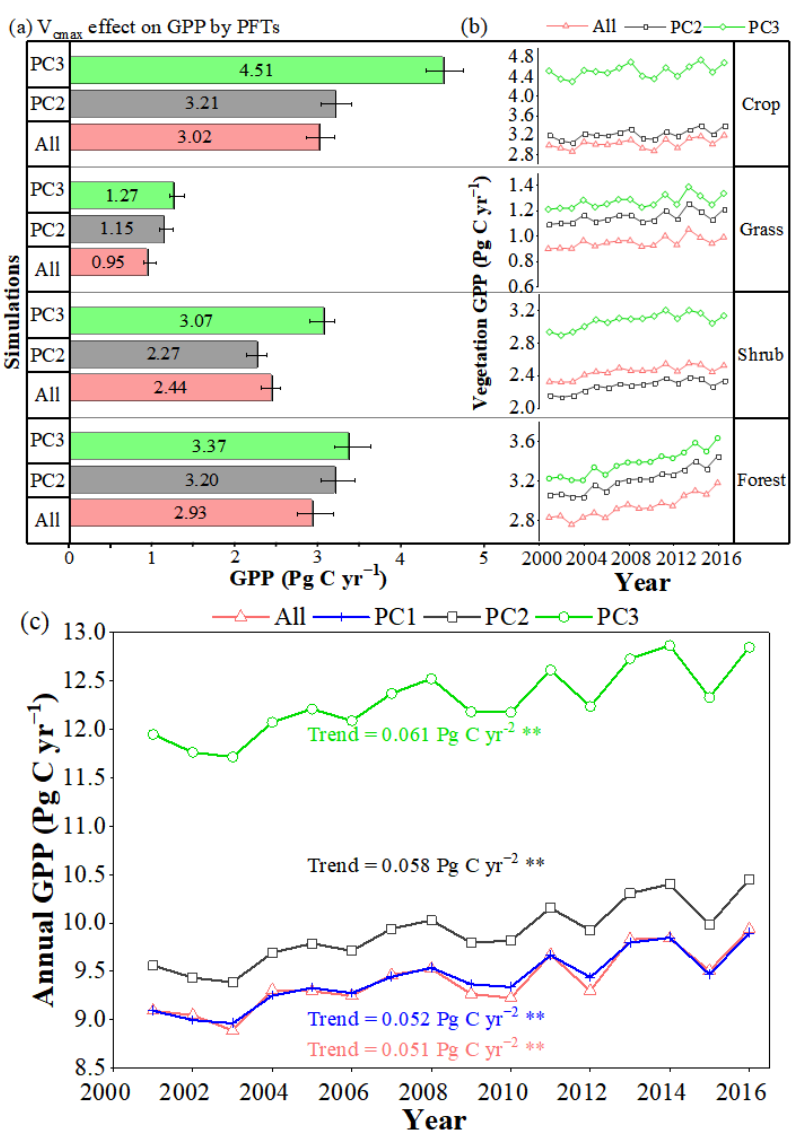
Figure 10. The V cmax change effect on GPP on annual time scales. ( a ) Difference in mean annual total GPP and ( b ) interannual variations in total GPP from 2001 to 2016 for the four dominant vegetation types (i.e., crop, forest, shrub, and forest) in the simulations w/o the V cmax constraint. ( c ) The V cmax change effect on interannual variations in total GPP across Europe simulated by the FGM in four model simulations (i.e., “All”, “PC1”, “PC2” and “PC3”) using the LCC-derived dynamic V cmax from 2001 to 2016 (“All”), LCC -derived dynamic V cmax from 2001 to 2016 (“PC1”), calibrated constant V cmax (“PC2”), and TRY -based constant V cmax (“PC3”) . Section 2.2.3 contains descriptions of these four simulation experiments. ** in (c) indicate increasing trends in the total annual GPP from 2001 to 2016 at p -value < 0.01.